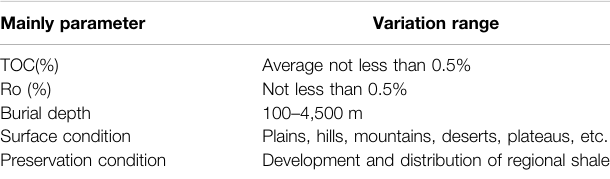
TABLE 1 | Reference standard for optimization of favorable areas of continental and transitional shale gas. Mainly parameter TOC(%)